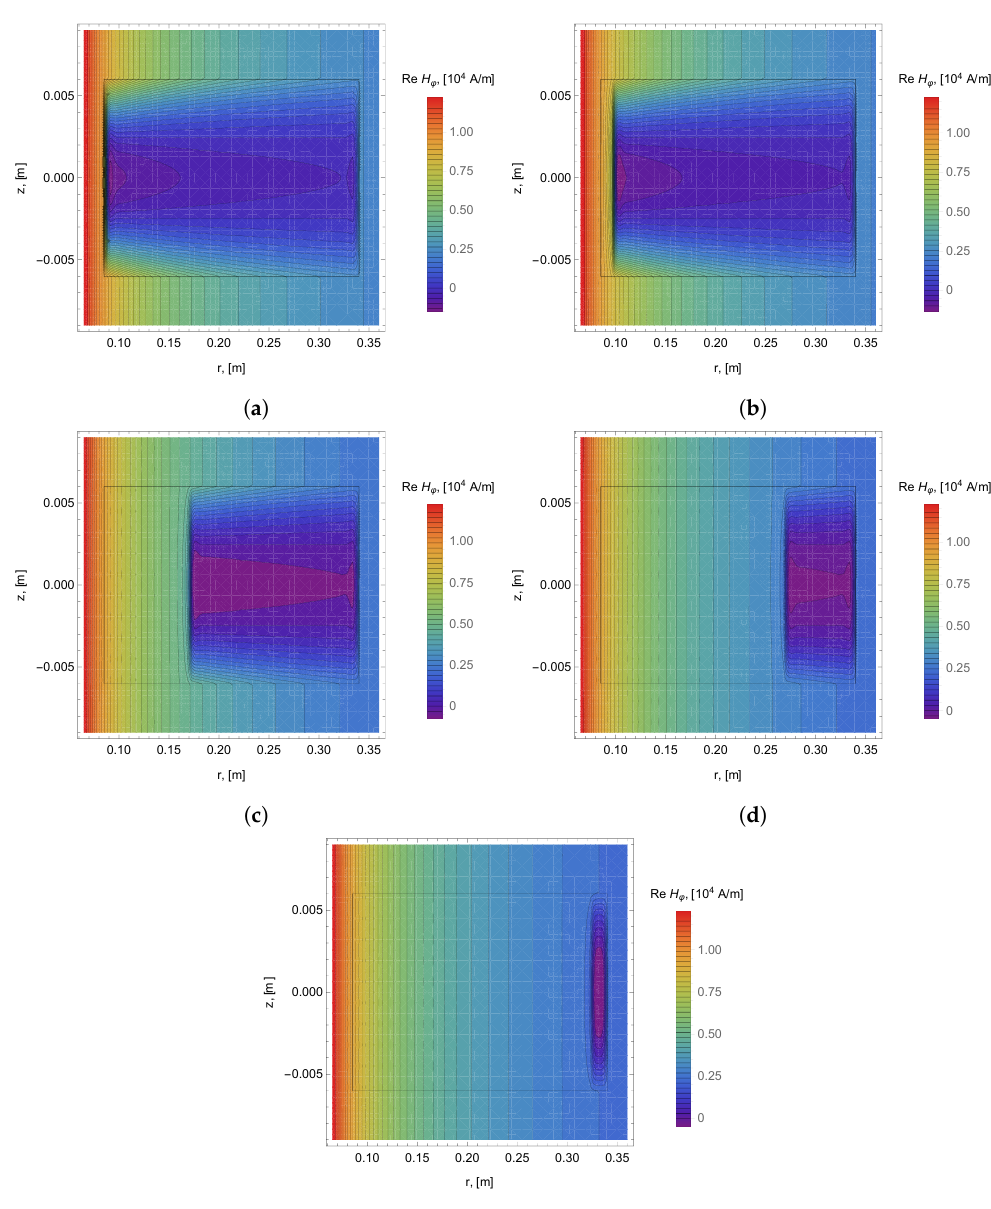
Figure 3. Magnetic field distribution inside the tank wall. ( a ) Case c = a . ( b ) Case c − a = 11.914mm. ( c ) Case c − a = 85mm. ( d ) Case c − a = 183.89mm. ( e ) Case c − a =